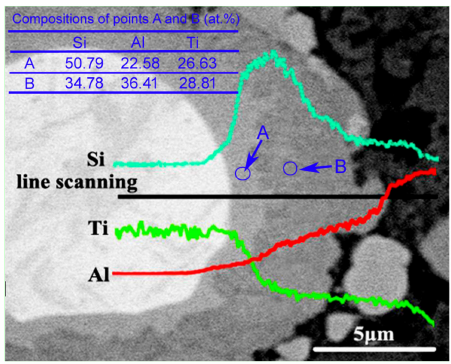
Figure 5. EDS analysis of a reinforcing particle formed at reheating temperature of 600 ◦